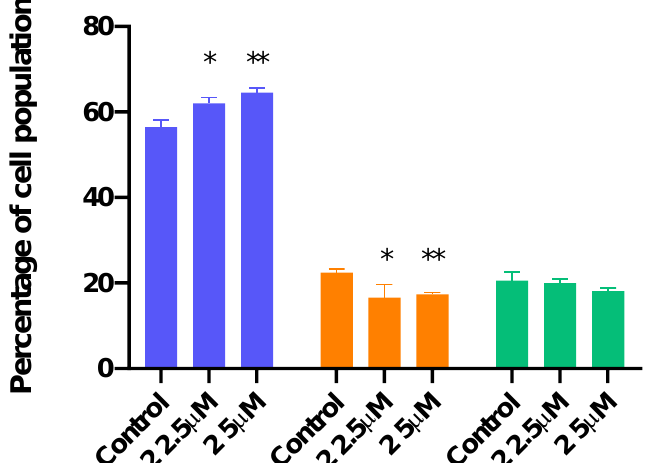
Figure 5. Effect of compound 2 on Hep-G2 cell cycle progression. Analysis of the percentage cell population in cell cycle stages revealed that 2 caused significant G0/G1 arrest. Hep-G2 cells were treated with 0.1% DMSO (control group), compound 2 at 2.5 μM or 5 μM for 48 h prior to cell cycle analysis. Bars show mean plus standard deviation; statistical analysis was performed via two-way ANOVA compared with the control group, * p < 0.0332; ** p < 0.0021.